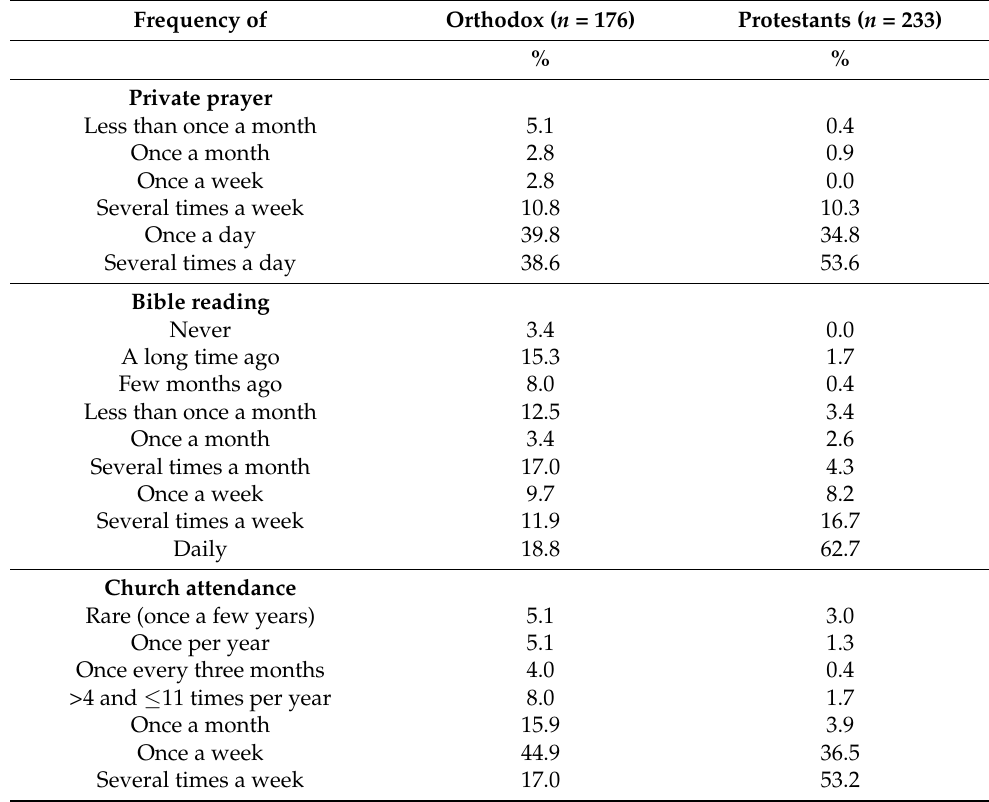
Table 7. Participant religious behaviour and general characteristics ( n =